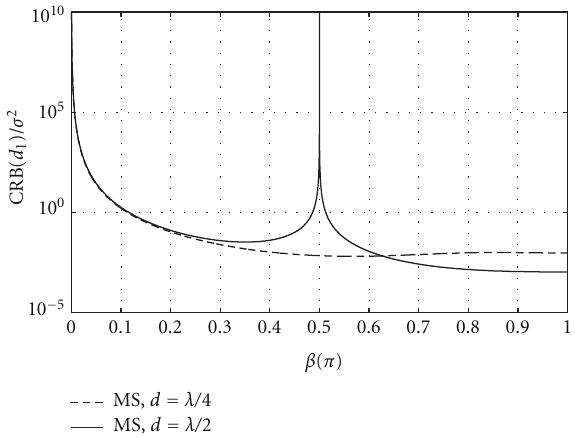
Figure 4: CRB( d 1 ) corresponding to scattering strength τ 1 = 1 = τ 2 and incidence angle α = 0, as a function of the observation angle β , for scatterers’ separations d = λ/ 4 and d = λ/